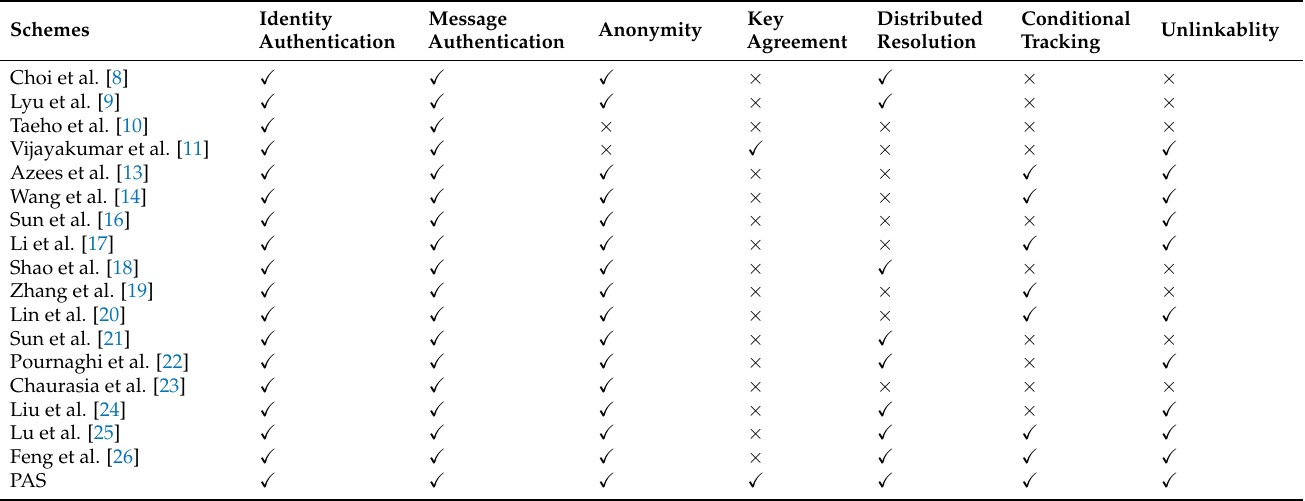
Table 1. Comparison of the related